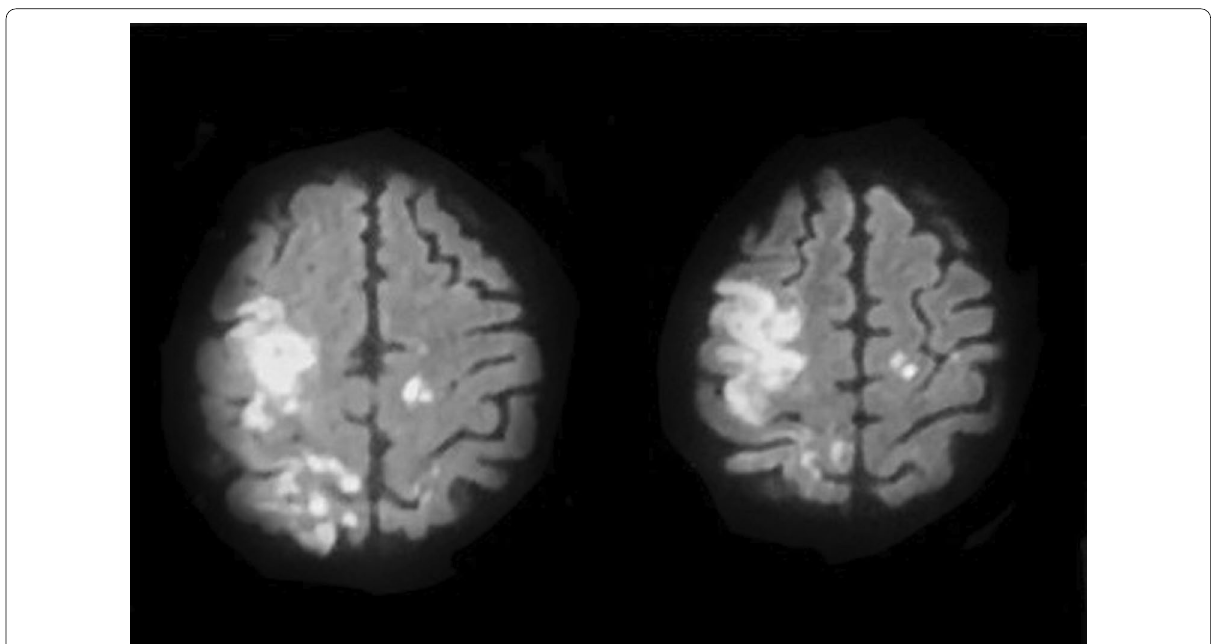
Fig. 4 Moderate-sized right high frontal cortical and sub-cortical lesion with heterogeneous signal and partly diffusion restriction going with venous